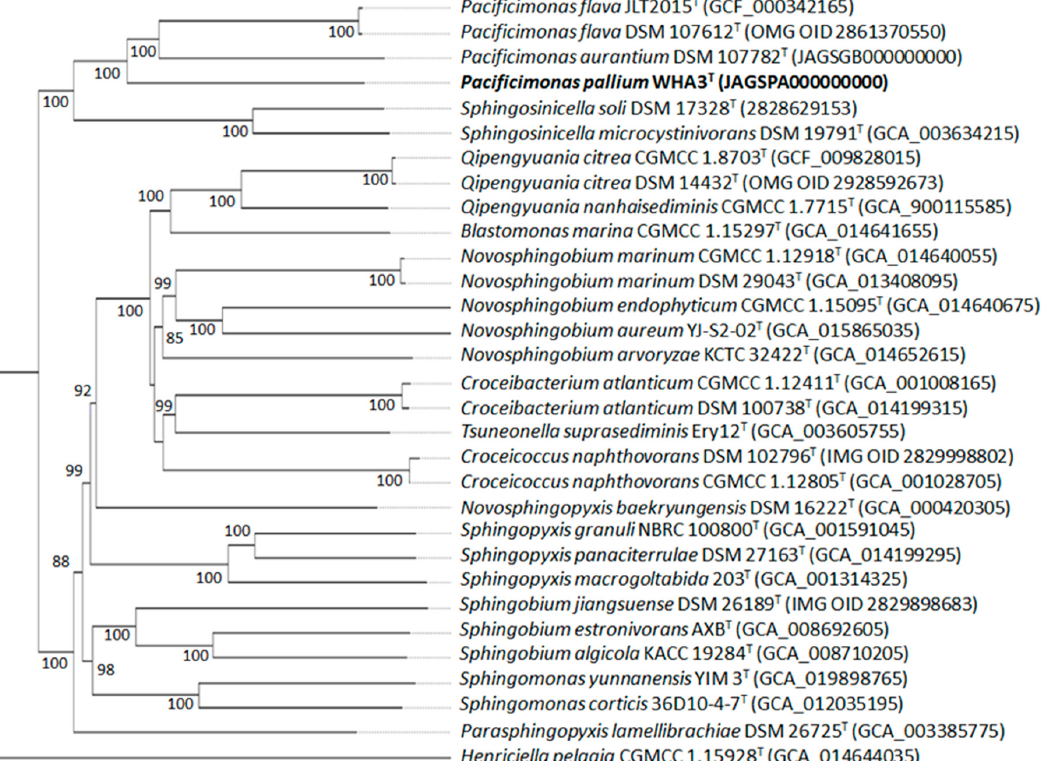
Pacificimonas flava DSM 107612 T , Pacificimonas aurantium DSM 107782 T ,